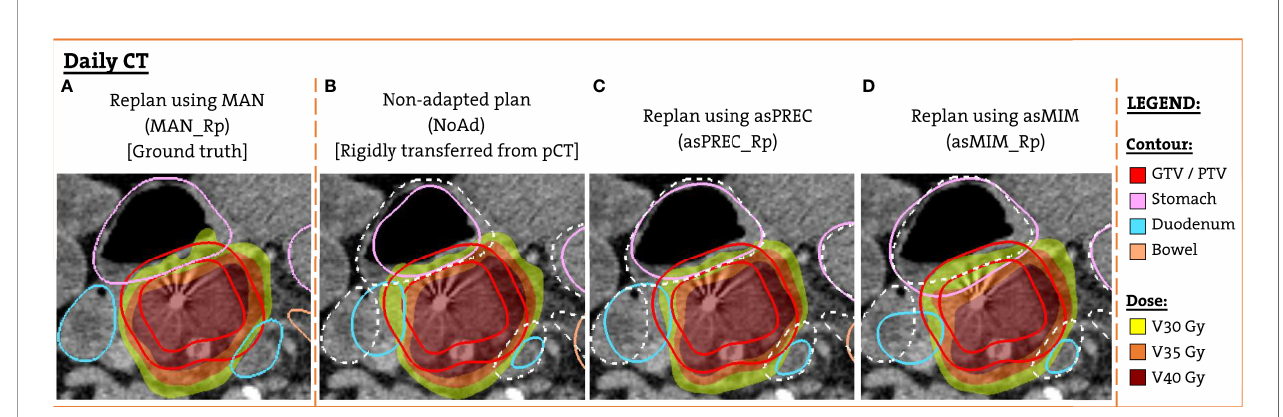
FIGURE 1 | Example patient FxCT scan with the different structure set and dose distribution used for the dosimetric evaluation. (A) Replanned dose optimized using manual contours (ground truth). (B) Non-adapted dose with planning anatomy rigidly transferred from the pCT (solid lines). (C) Replanned dose optimized using contours obtained with Precision DIR (solid lines). (D) Replanned dose using contours from MIM DIR (solid lines). For (B – D) manual contours are also overlaid (dashed white